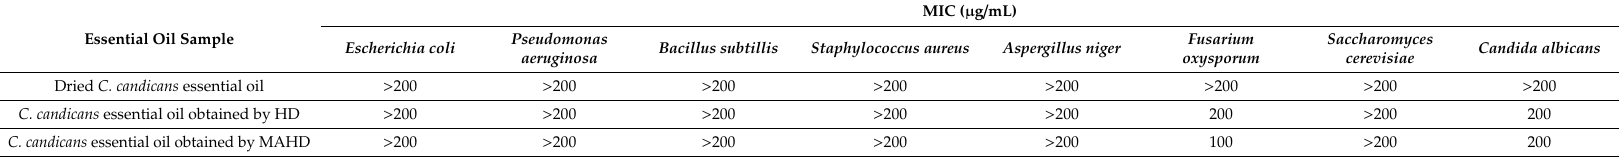
Table 7. Antimicrobial activity of C. candicans essential oil